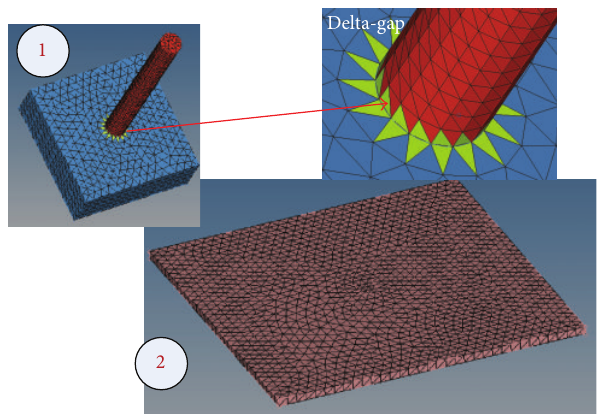
Figure 6: The domain partition of the monopole antenna mounted on a PEC tablet.